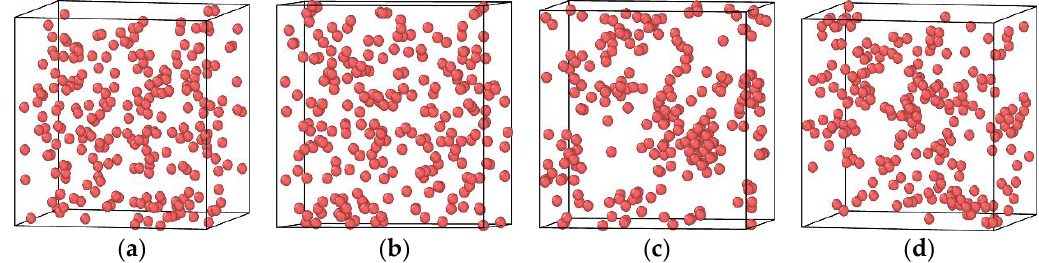
Figure 6. Cu atom distribution in the Fe-3.5Cu alloy before aging and after aging at 1050 K for 200 ns when the vacancy content is different ( a ) before aging ( b ) without vacancies ( c ) with 0.1 at% vacancies ( d ) with 0.2 at% vacancies.